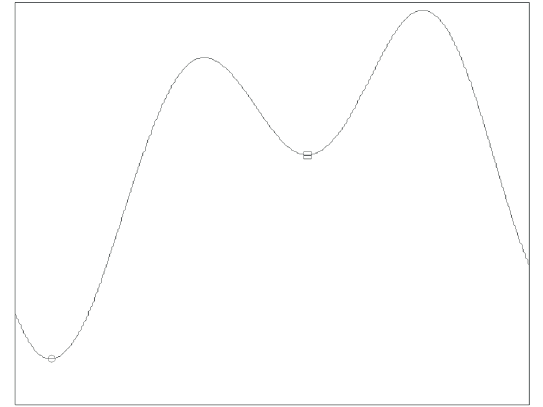
Fig. 1. An example of when the golden-section search finds a local minimum (the squared point to the right), whereas the global minimum (the circled point to the left) is omitted.